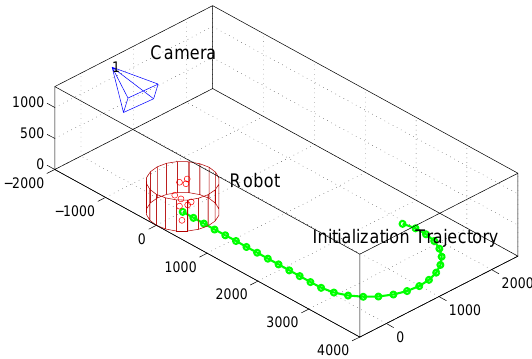
Figure 8. Initialization trajectory of the robot in the experiment based on synthetic